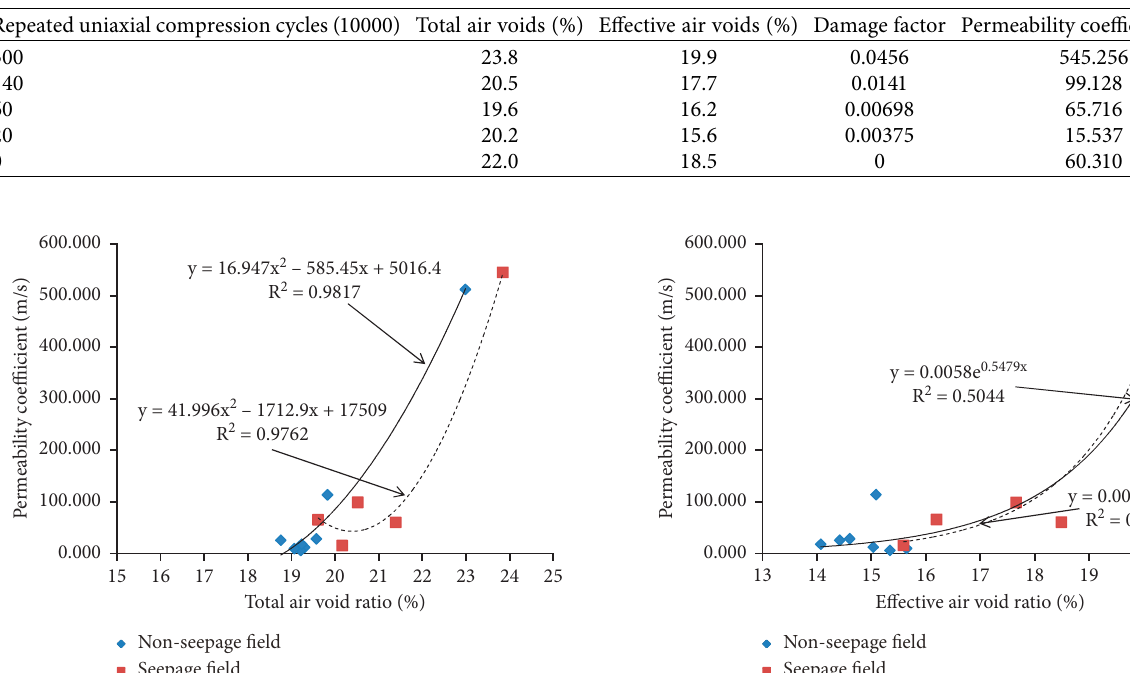
Table 9: Repeated uniaxial compression test results with seepage field.